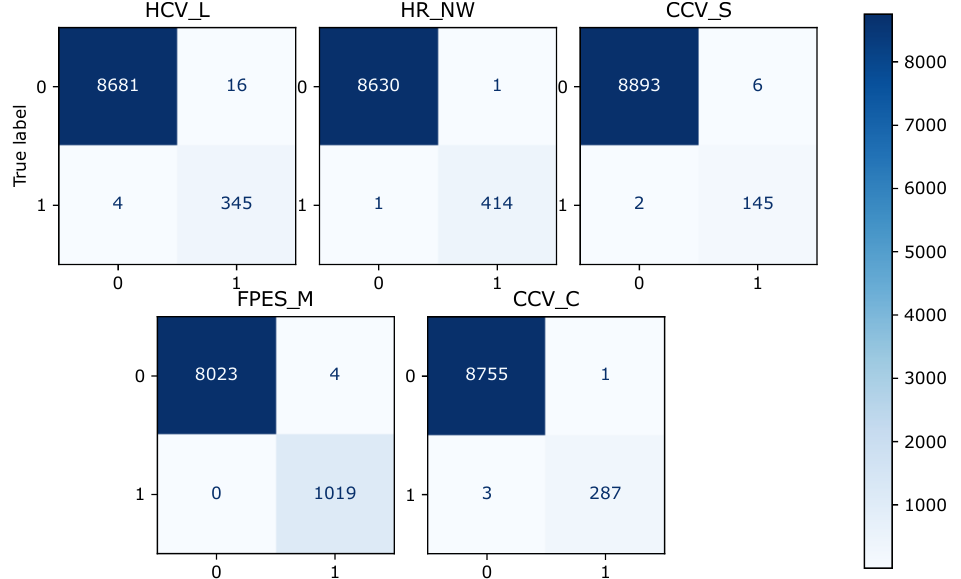
Figure 4. Diagram of the confusion matrix of different fault classes for the random forest model and for five fault